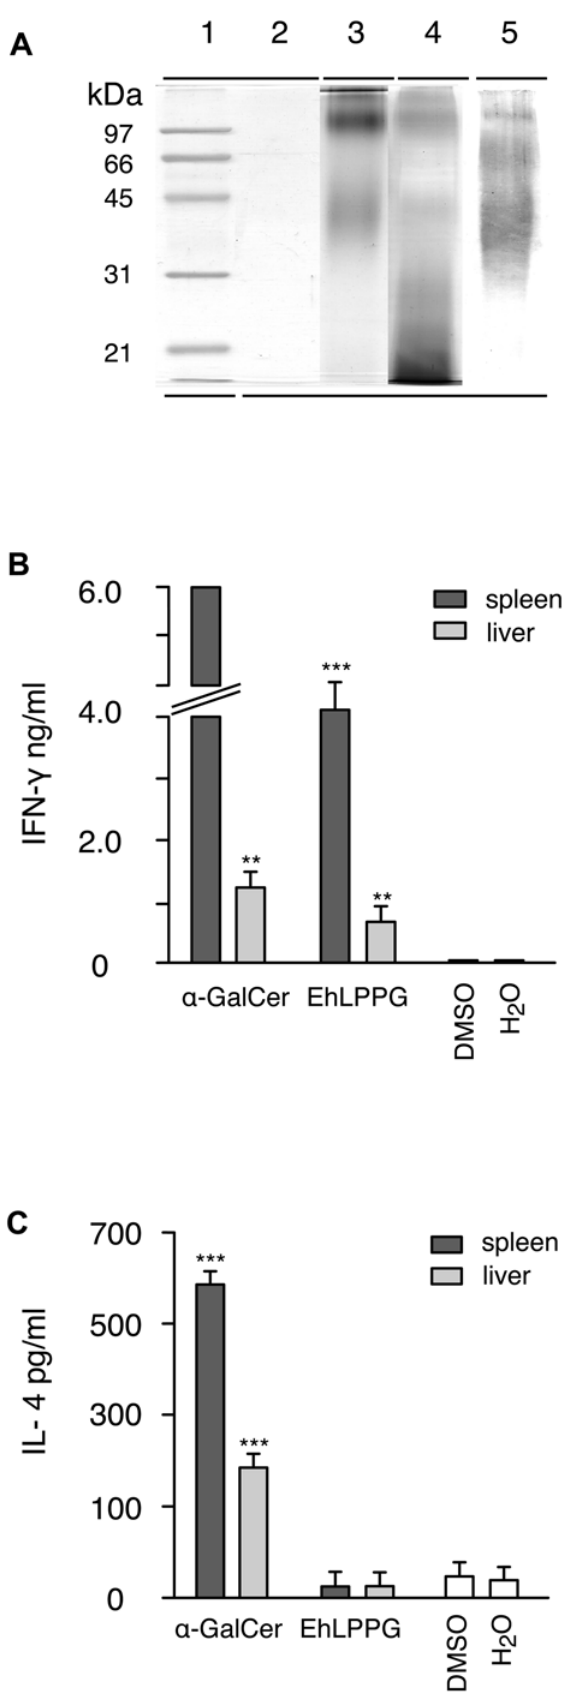
Figure 2. EhLLPG purified from membranes of E. histolytia trophozoites stimulates production of IFN- c but not of IL-4 by splenocytes and liver lymphocytes. (A) EhLPPG was separated by a 12% SDS-PAGE and developed by the following staining procedures: colloidal Coomassie (lane 2), periodic acid-Schiff staining (lane 3), a modified silver nitrate staining (lane 4) [61] and a Western-blot of EhLPPG developed with mAb EH5 (lane 5) [28]. A low molecular weight protein standard (BioRad), stained with colloidal Coomassie, is shown in lane 1. The negative stain in lane 2 revealed the abscence of major protein content, a positive staining in lane 3 and 4 evidenced the high glycosylation of the molecule and the detection by EH5 in lane 5 proved the identity of E. histolytica LPPG. (B,C) APC (1x10 5 ) were pulsed for 3 h with 2 m g a -GalCer or EhLPPG prior to co-cultivation with spleen or gradient separated liver lymphocytes (4x10 5 ). Supernatants were taken after 48 h and tested for the presence of IFN- c (B) and IL-4 by ELISA (C). IFN- c produced compared to DMSO control * ( p , 0.05); ** ( p , 0.005), *** ( p , 0.001); Mann Whitney U-test. The results were obtained from experiments repeated at least 5